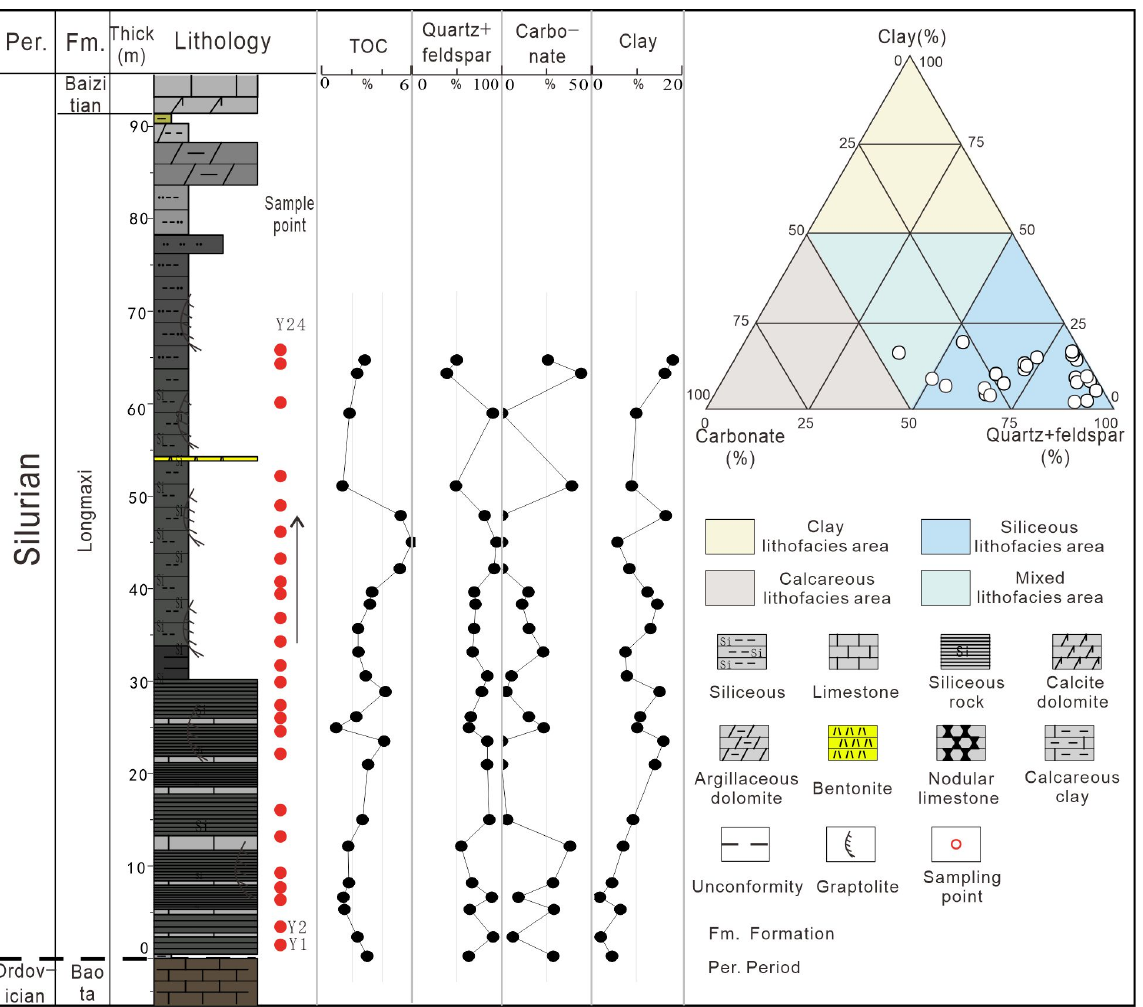
Figure 3. The sampling location in the Longmaxi Formation Stratigraphic column and the Ternary diagram of mineral composition.